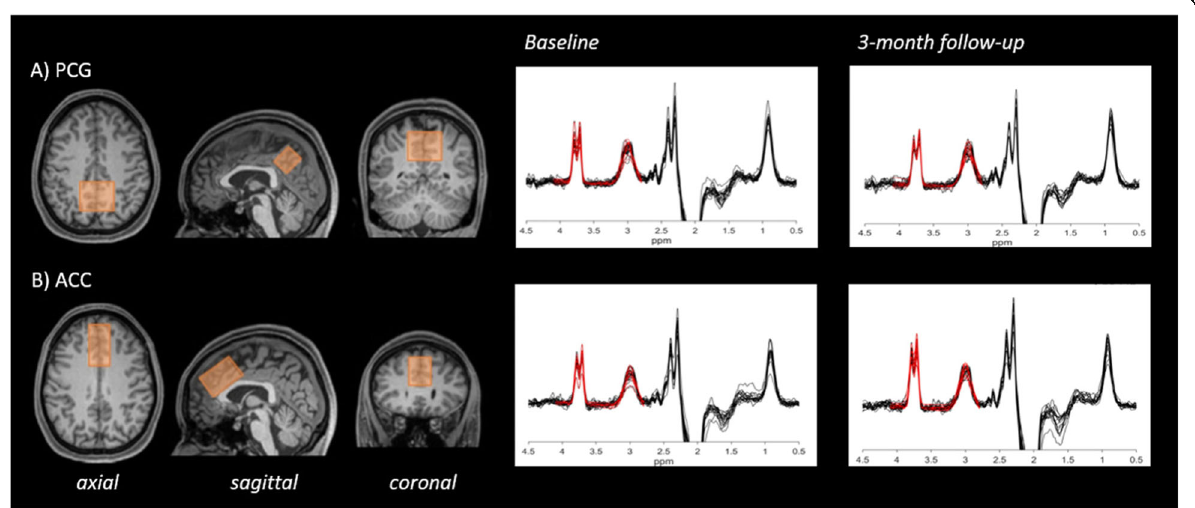
Fig. 1 Exemplary voxel placement and an overlay of all spectra from A) PCG and B) ACC at baseline and 3-month